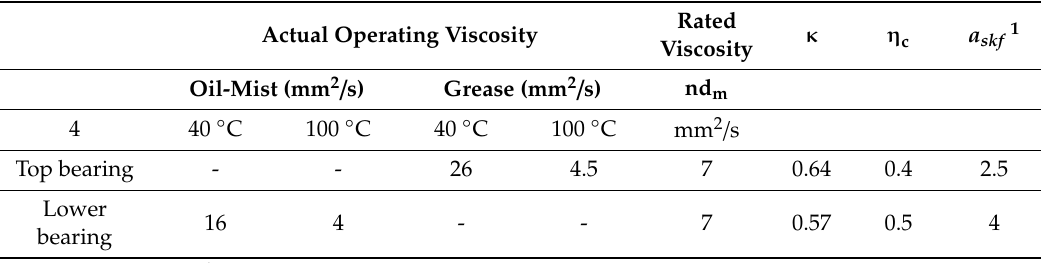
Table A6. Values of life modification factor